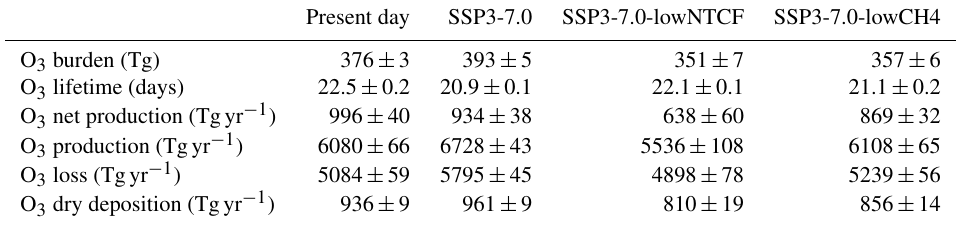
Table 4. Comparison of the tropospheric O 3 budget under present-day (2004–2014) and future conditions